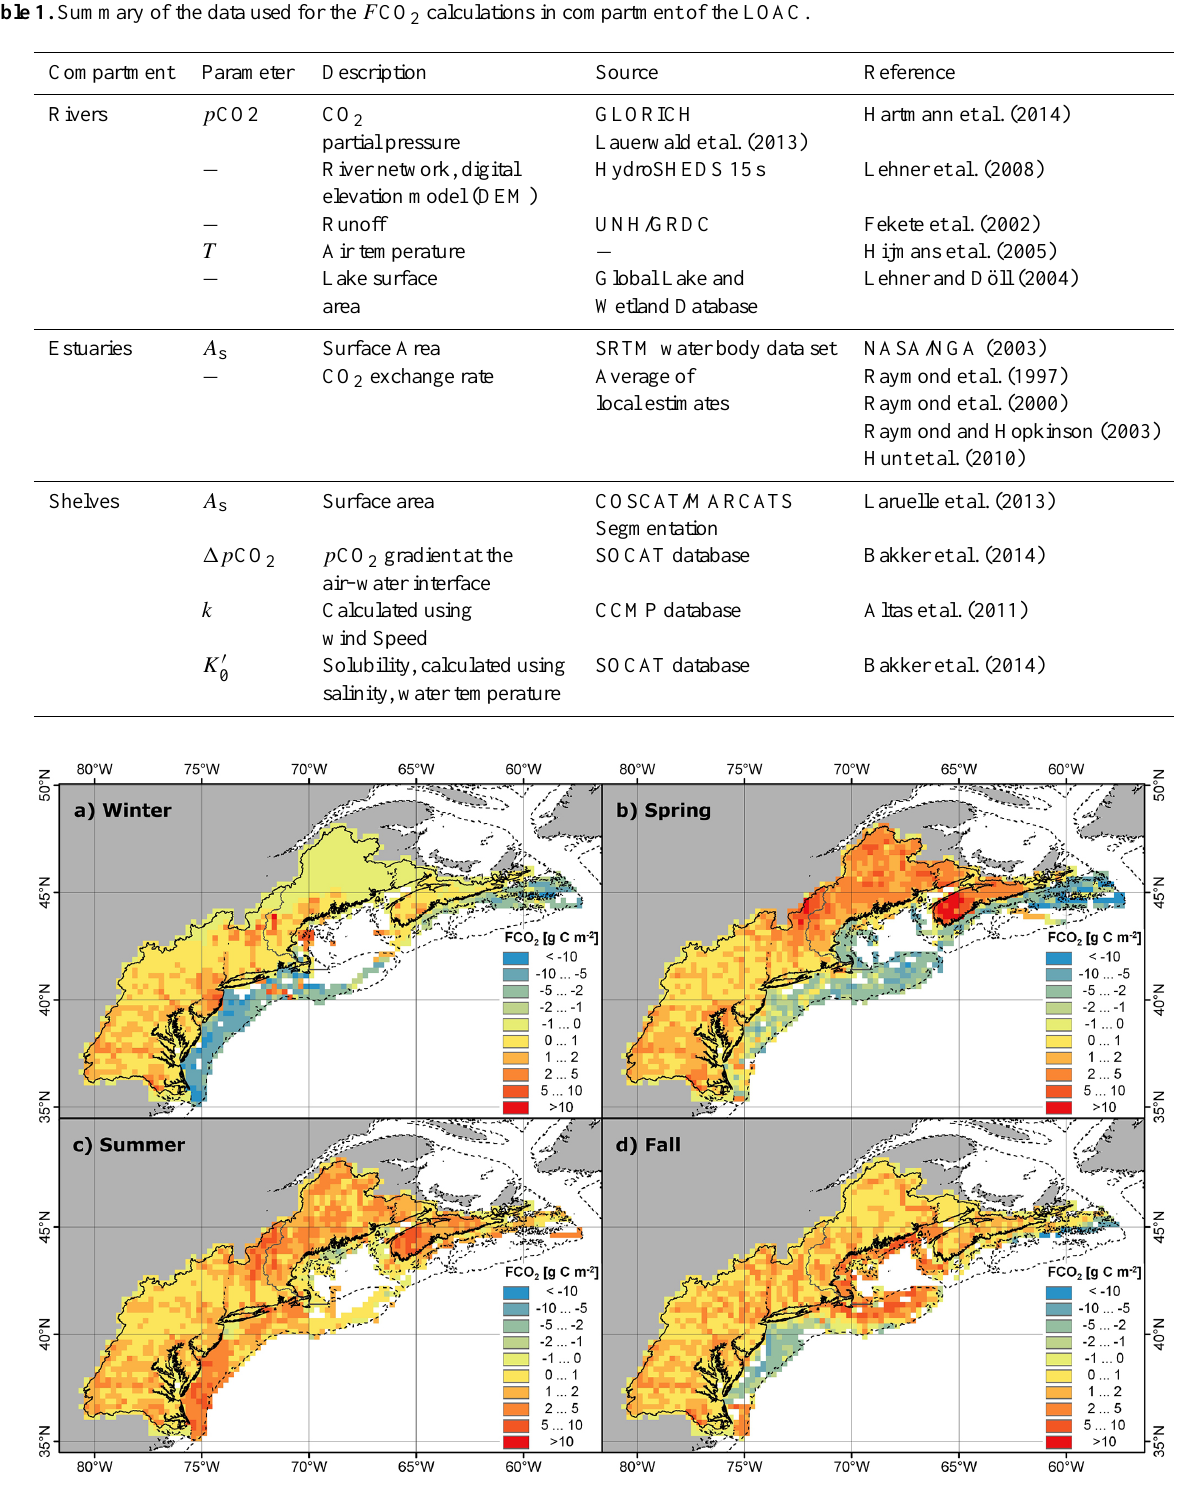
Figure 2. Spatial distribution of the CO 2 exchange with the atmosphere in rivers and continental shelf waters aggregated by seasons. The fluxes are net F CO 2 rates averaged over the surface area of each 0.25 ◦ cell and a period of 3 months. Positive values correspond to fluxes towards the atmosphere. Winter is defined as January, February, and March, Spring as April, May, and June, and so